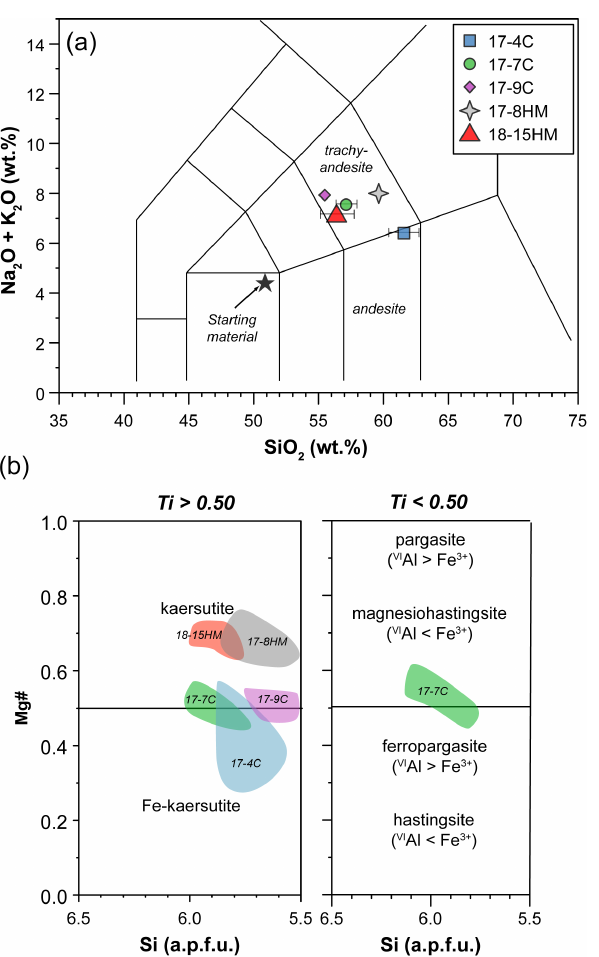
Figure 4. (a) Major element composition of glass (TAS dia- gram – normalized to anhydrous 100wt%) and (b) Mg value (Mg# = Mg + Fe / Mg) versus Si (a.p.f.u.) of amphibole (according to classification of Leake et al., 1997). Labels in (b) refer to the experimental runs (see Table 1).